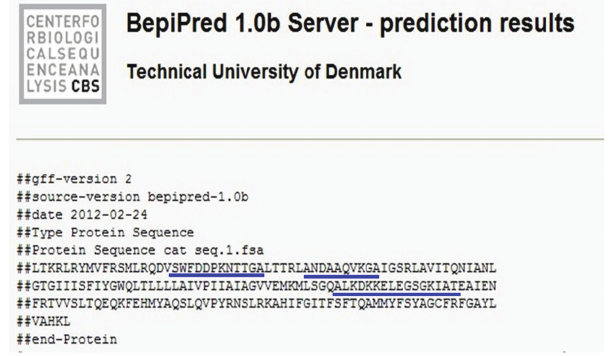
Table 4: Fd homology analysis of clone number 29 displaying the sequences with higher homology